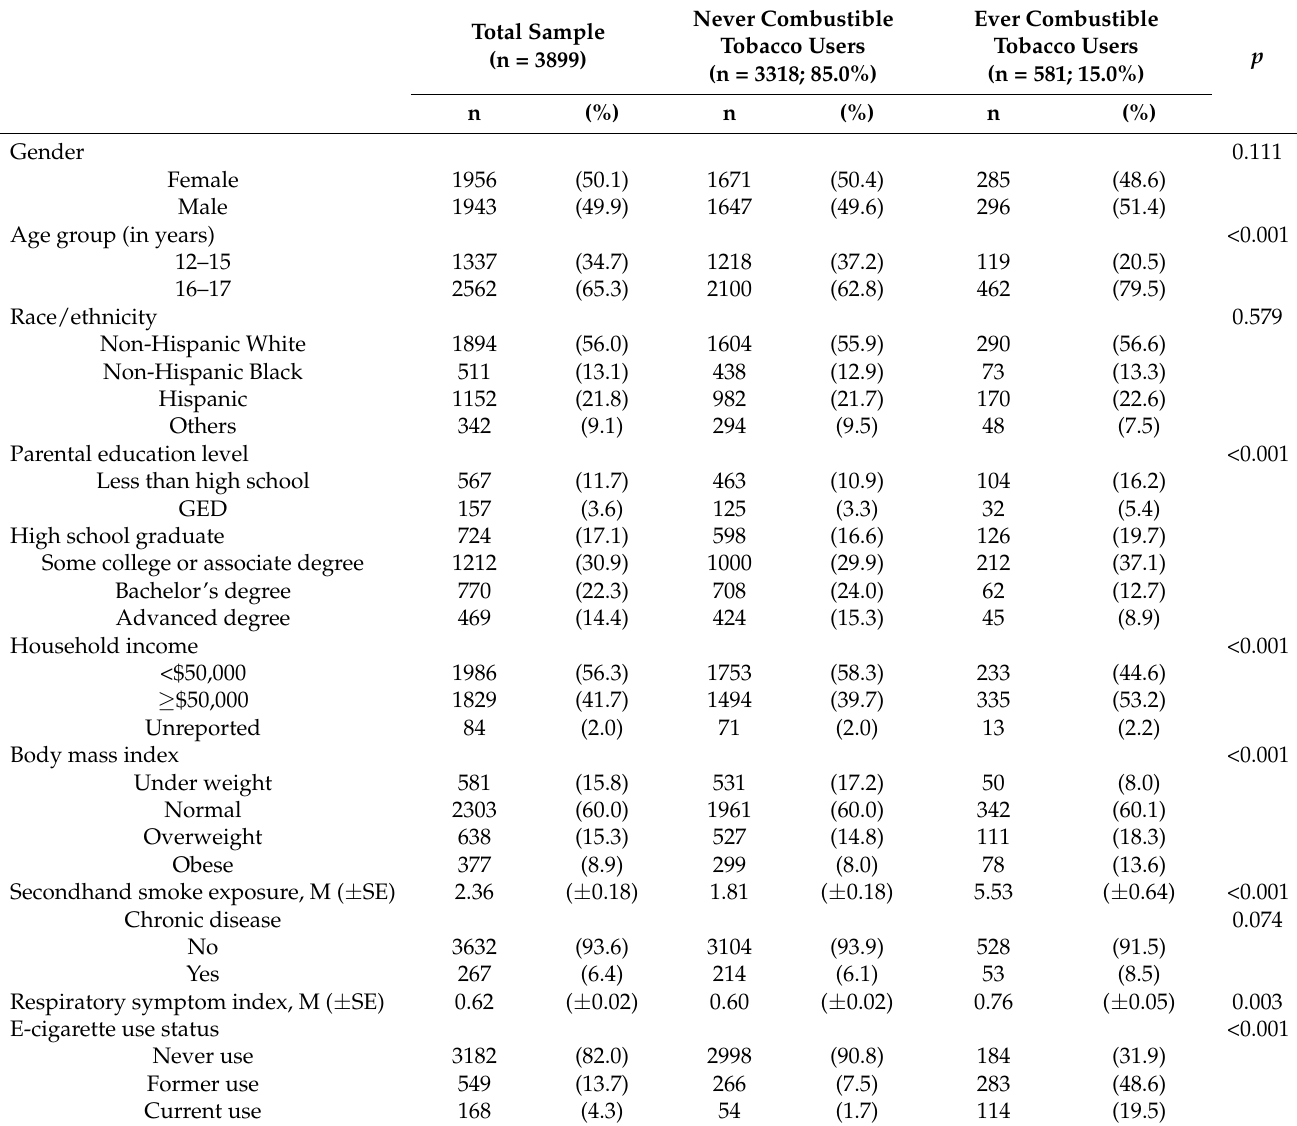
Table 1. Characteristics of youth sample of the PATH Study Wave